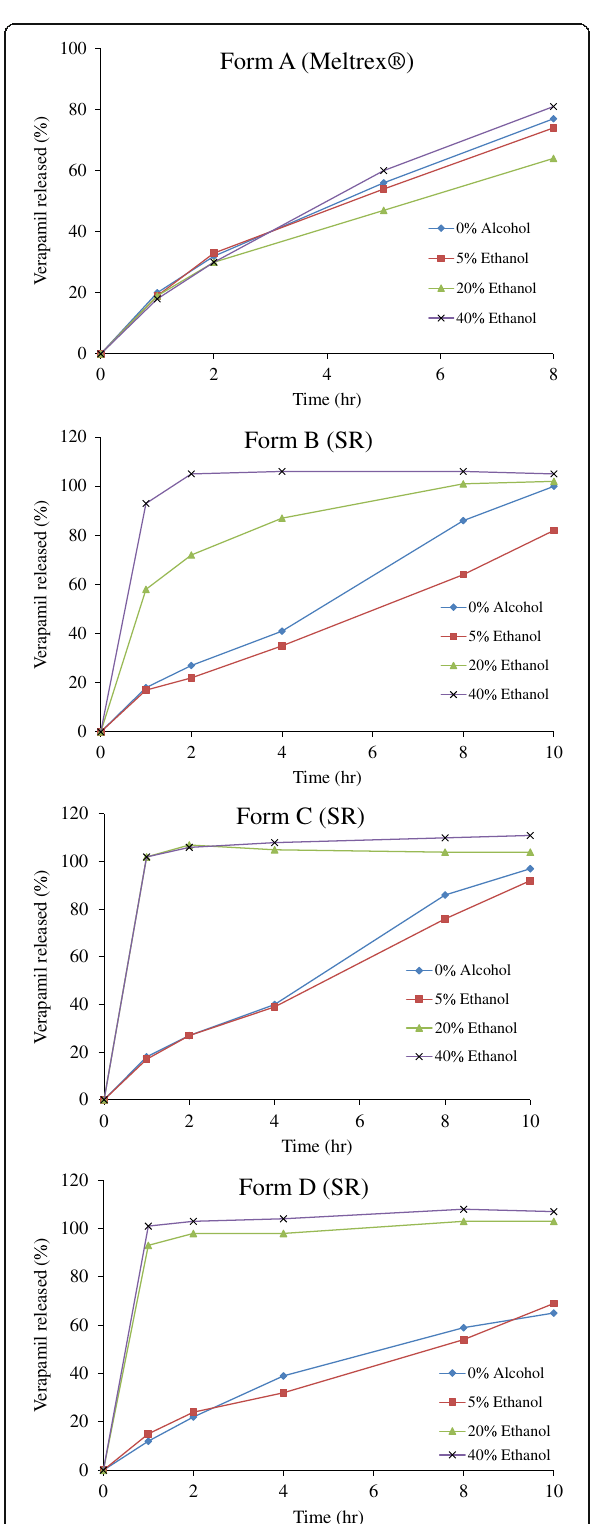
Fig. 30 Effect of ethanol concentration on release of paracetamol from hot melt extruded pellets (closed legends = 0% ethanol, open legends = 40% ethanol) (Jedinger et al. 2015)